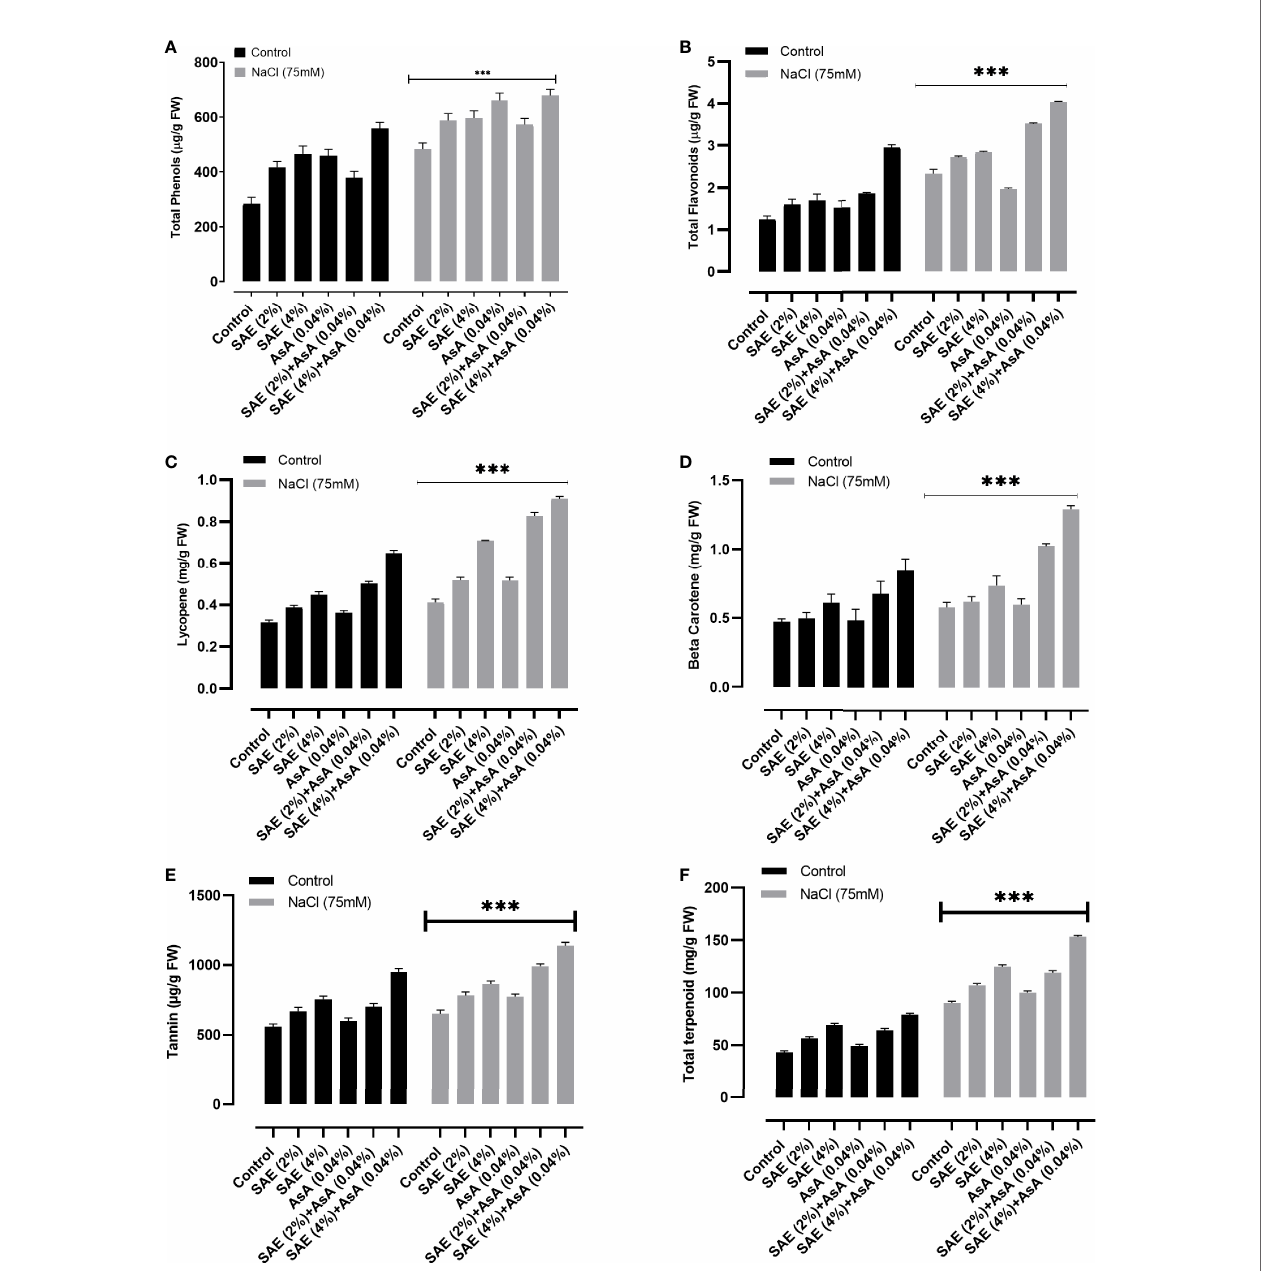
FIGURE 6 | Effect of SAE on secondary metabolites of A. esculentus grown under salt stress. (A) Total phenols; (B) fl avonoids; (C) lycopene; (D) b -carotene; (E) tannins; (F) terpenoids. Error bars of quantitative data represent ± SEM (*** p < 0.005). FW, fresh